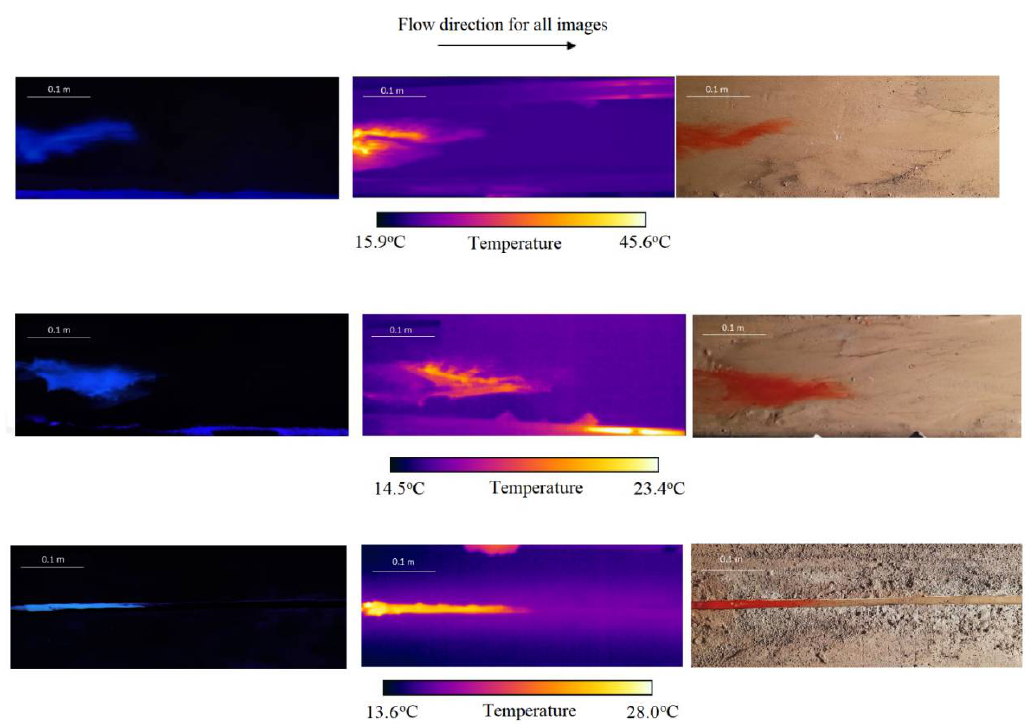
Figure 4. Comparison between imaging of the quinine tracer under ultraviolet light ( left ), the thermal tracer snapshots ( centre ), and the dye tracer ( right ), for the flat plane ( top ), eroded ( middle ), and artificial rill ( bottom ) surfaces. Scales are indicated on the images.